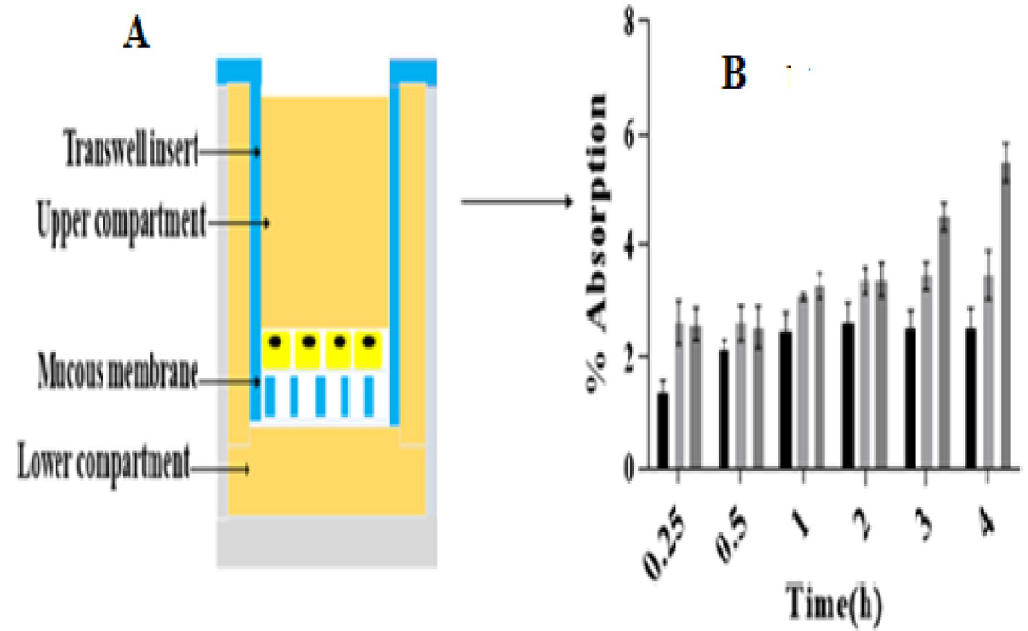
4 h of experiment. Data is shown as mean ± SD (n = 3).